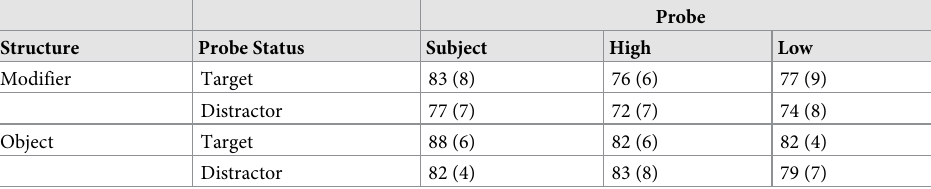
Table 7. Accuracy in post-probe recognition grammaticality judgment task.